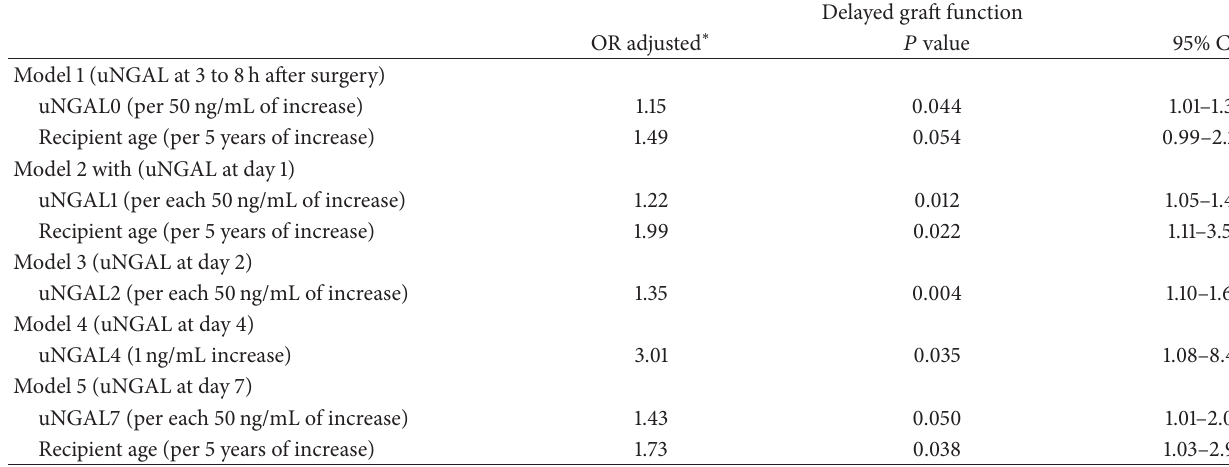
Table 6: Association of uNGAL with delayed graft function by multivariable analysis (logistic regression).